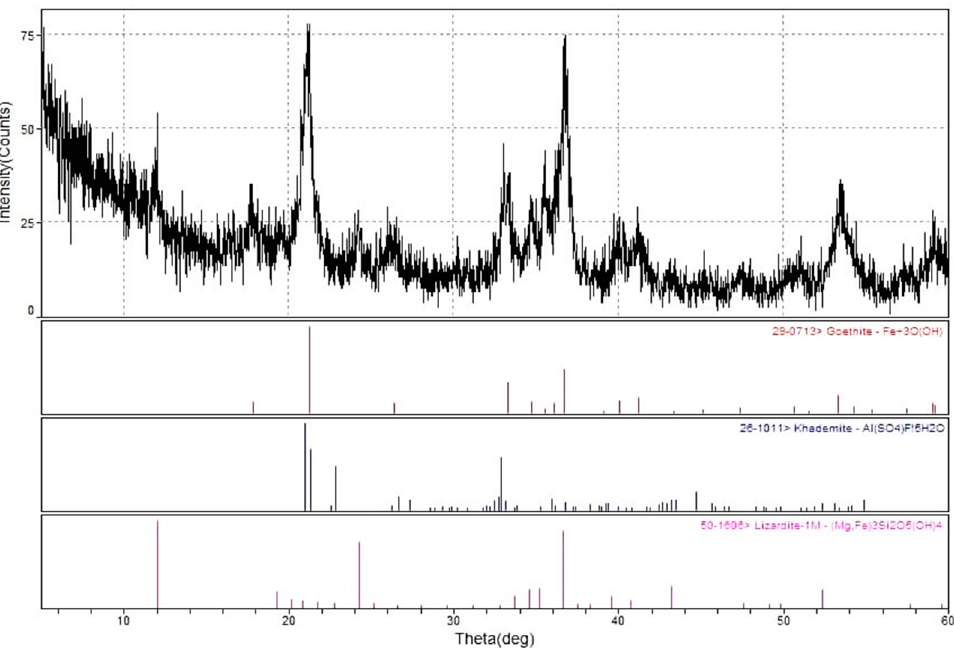
Figure 3. Intensity peaks as reported by XRD.